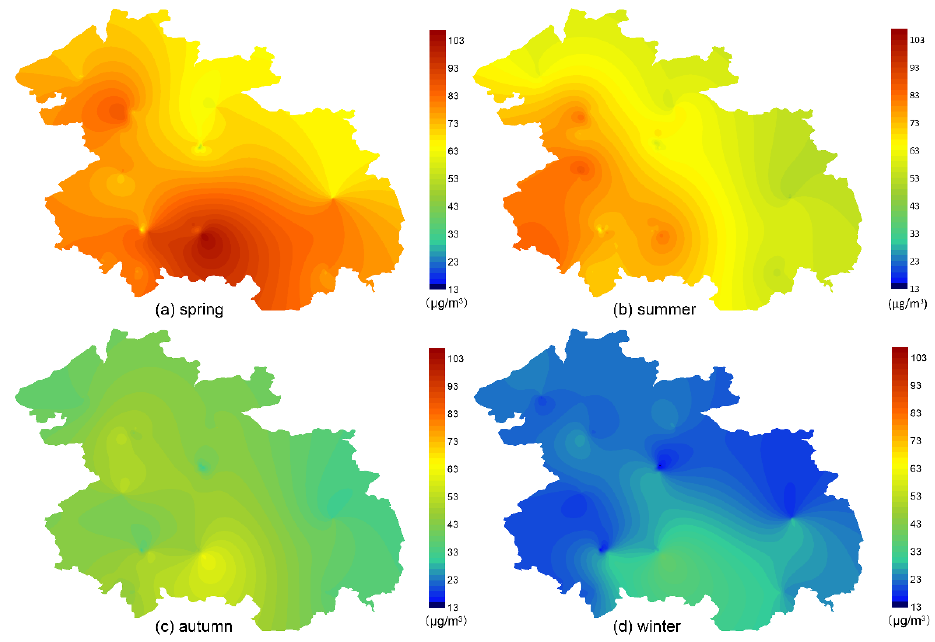
Figure 4. Spatial distribution of seasonal average concentration of O 3 . Igor G. Zurbenko et al. [44] showed that the seasonality of the ozone production rate is directly dependent upon the seasonality of solar radiation. Seasonally, the solar radia- tion is relatively higher in spring and lowest in winter. High ozone concentration in spring may also be caused by large-scale air mass transport or stratospheric exchange caused by